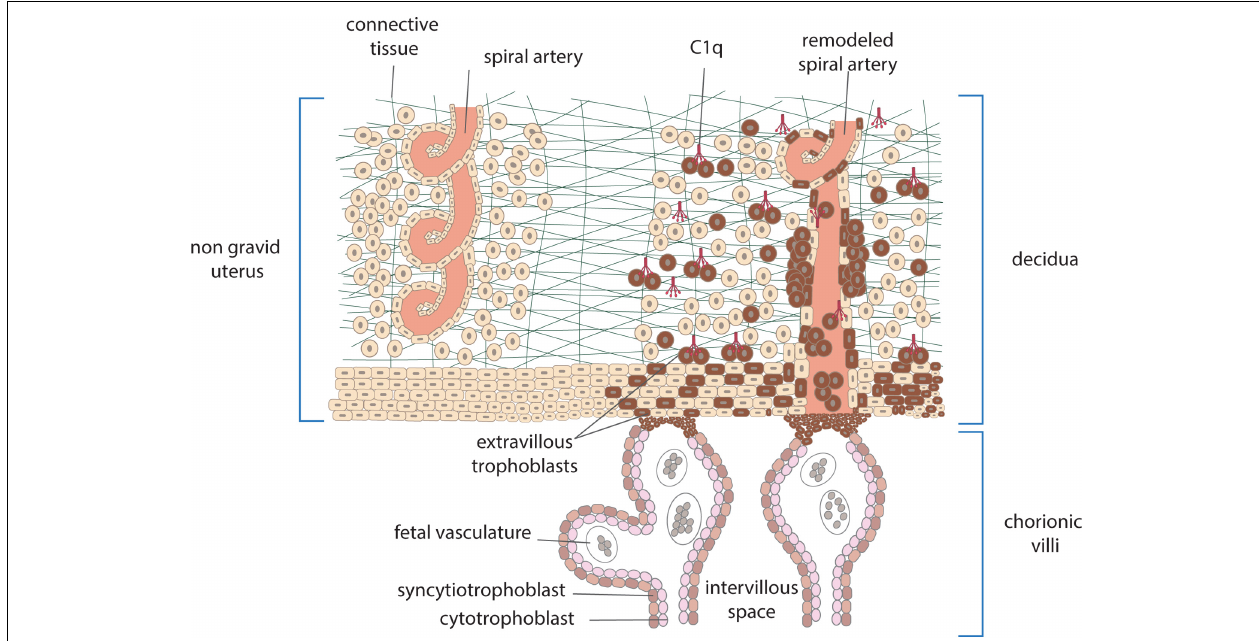
FIGURE 2 | Schematic representation of human placenta showing anchoring villi attached to maternal decidua. Extravillous trophoblasts depart from the villi and invade the decidua surrounding the spiral arteries. Other cells enter the lumen of the arteries as endovasculat trophoblasts and partially replace lining endothelial cells. C1q produced by trophoblasts is used to promote their migration and interaction with endothelial cells.